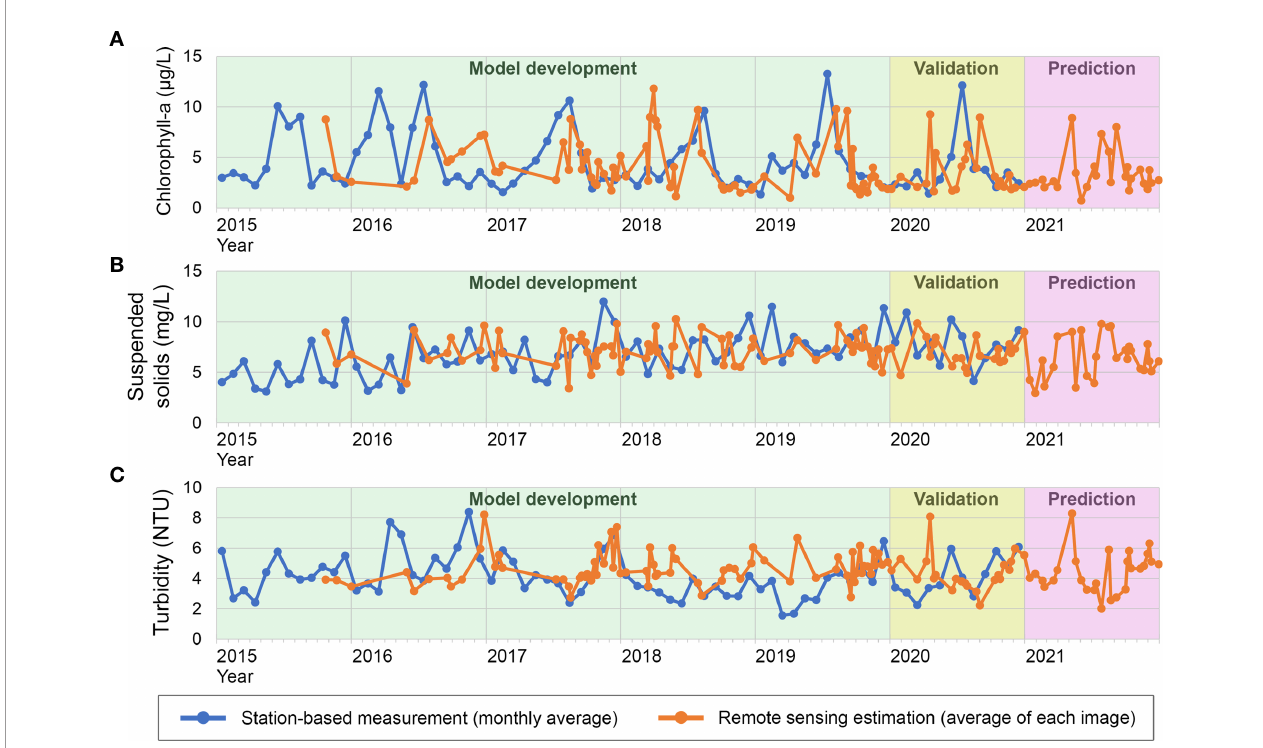
FIGURE 4 | Time-series line chart of (A) chlorophyll-a concentration, (B) suspended solids, and (C) turbidity in Hong Kong water from 2015 to 2021, obtained from station-based measurement (blue lines) and remote sensing estimation (orange lines) respectively. For station-based measurement, values are calculated as the mean value of all measurements in all locations taken in the same month. For remote sensing estimations, values are calculated as the mean of all estimated values at the locations of monitoring stations in each image. Note that the two measurement methods also differ in sampling locations (e.g. affected by cloud cover and water pixels) and frequencies (e.g. image acquisition